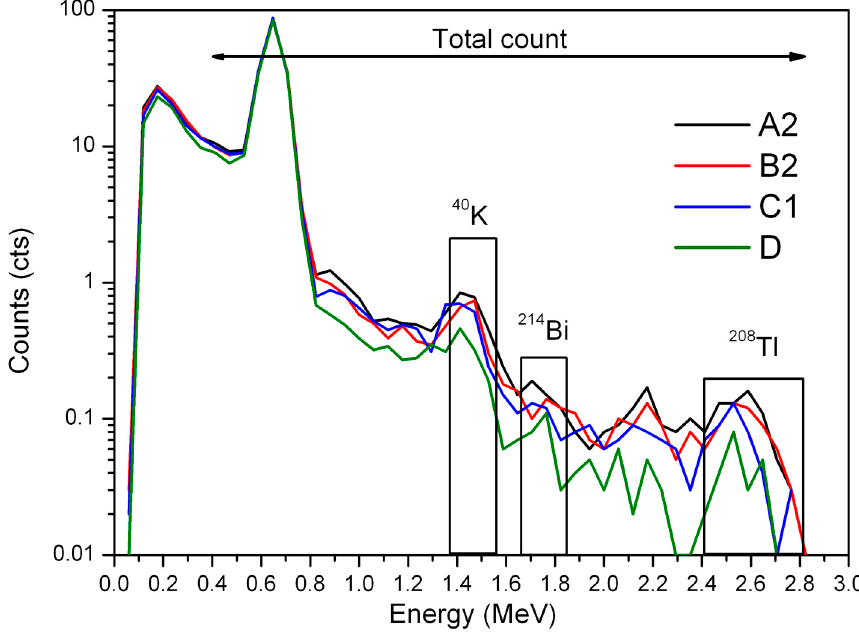
Figure 2. Recorded spectra for measurements A2, B2, C1, and D with indication of the emission bands of 40 K (1.461 MeV), 214 Bi (1.764 MeV), which is used for the estimation of “equivalent of uranium” or eU, and 208 Tl (2.615 MeV), which is used for the estimation of “equivalent of thorium” or eTh, with the corresponding peaks and total count energy range used for obtaining dose rates.